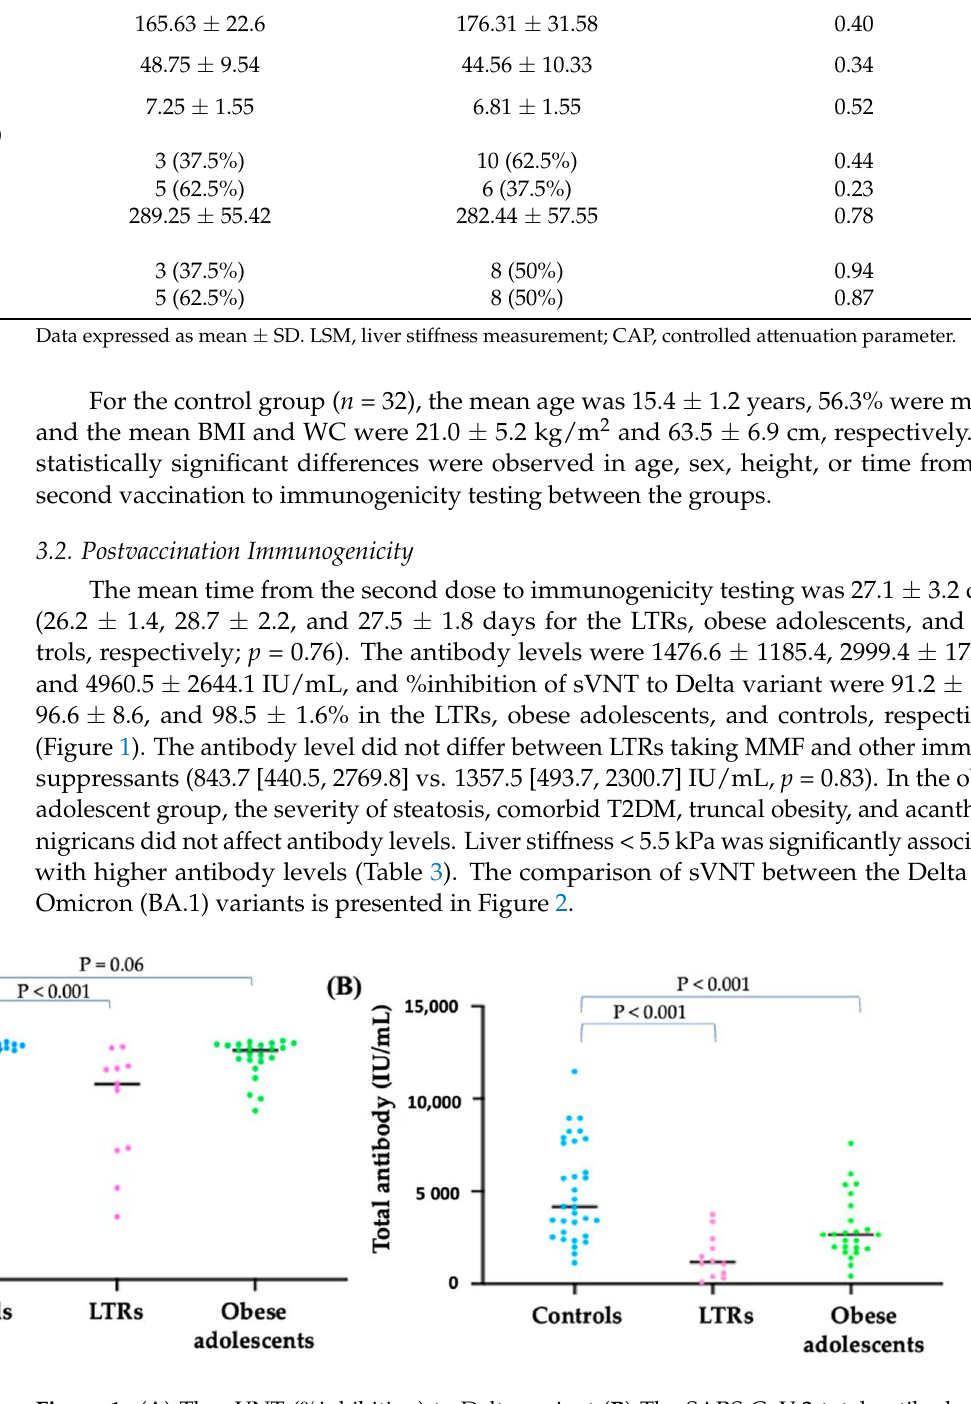
Figure 1. ( A ) The sVNT (%inhibition) to Delta variant ( B ) The SARS-CoV-2 total antibody after second dose of vaccination in healthy controls, LTRs, and obese